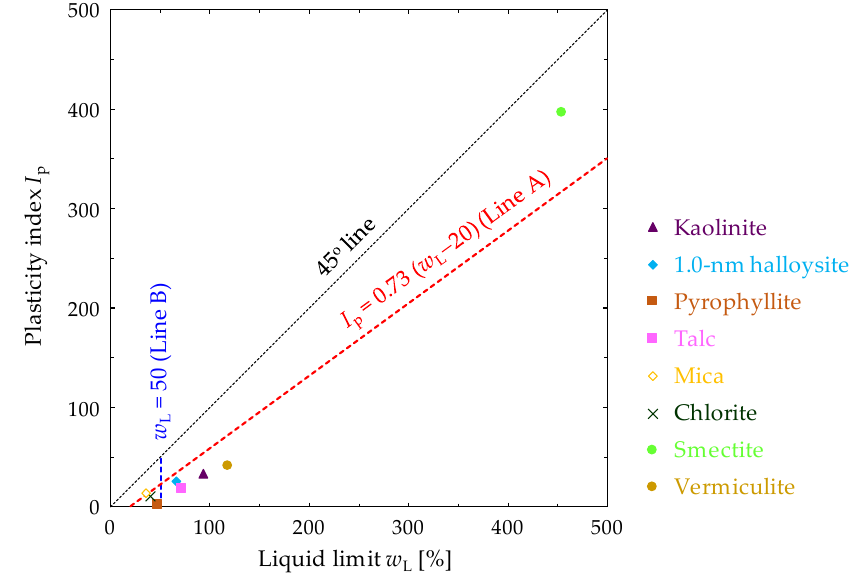
Figure 3. Plasticity chart of clay mineral powder samples.